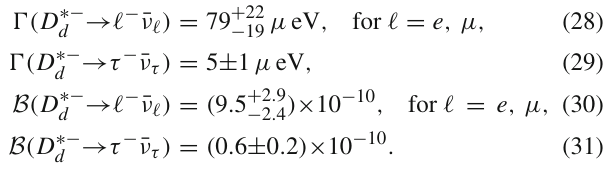
a Without QCD radiative corrections. b With QCD radiative corrections c With constituent quark masses for the light quarks m d With current quark masses for the light quarks m e With Coulomb plus linear potential model f With Coulomb plus harmonic oscillator potential model g With the Gaussian type wave functions h With the power-law type wave functions i With Coulomb plus linear potential model j With a dilation parameter κ = 0.54 GeV k With a dilation parameter κ = 0.68 GeV l With Martin potential model [72] m With Cornell potential model [73] n With logarithmic potential model